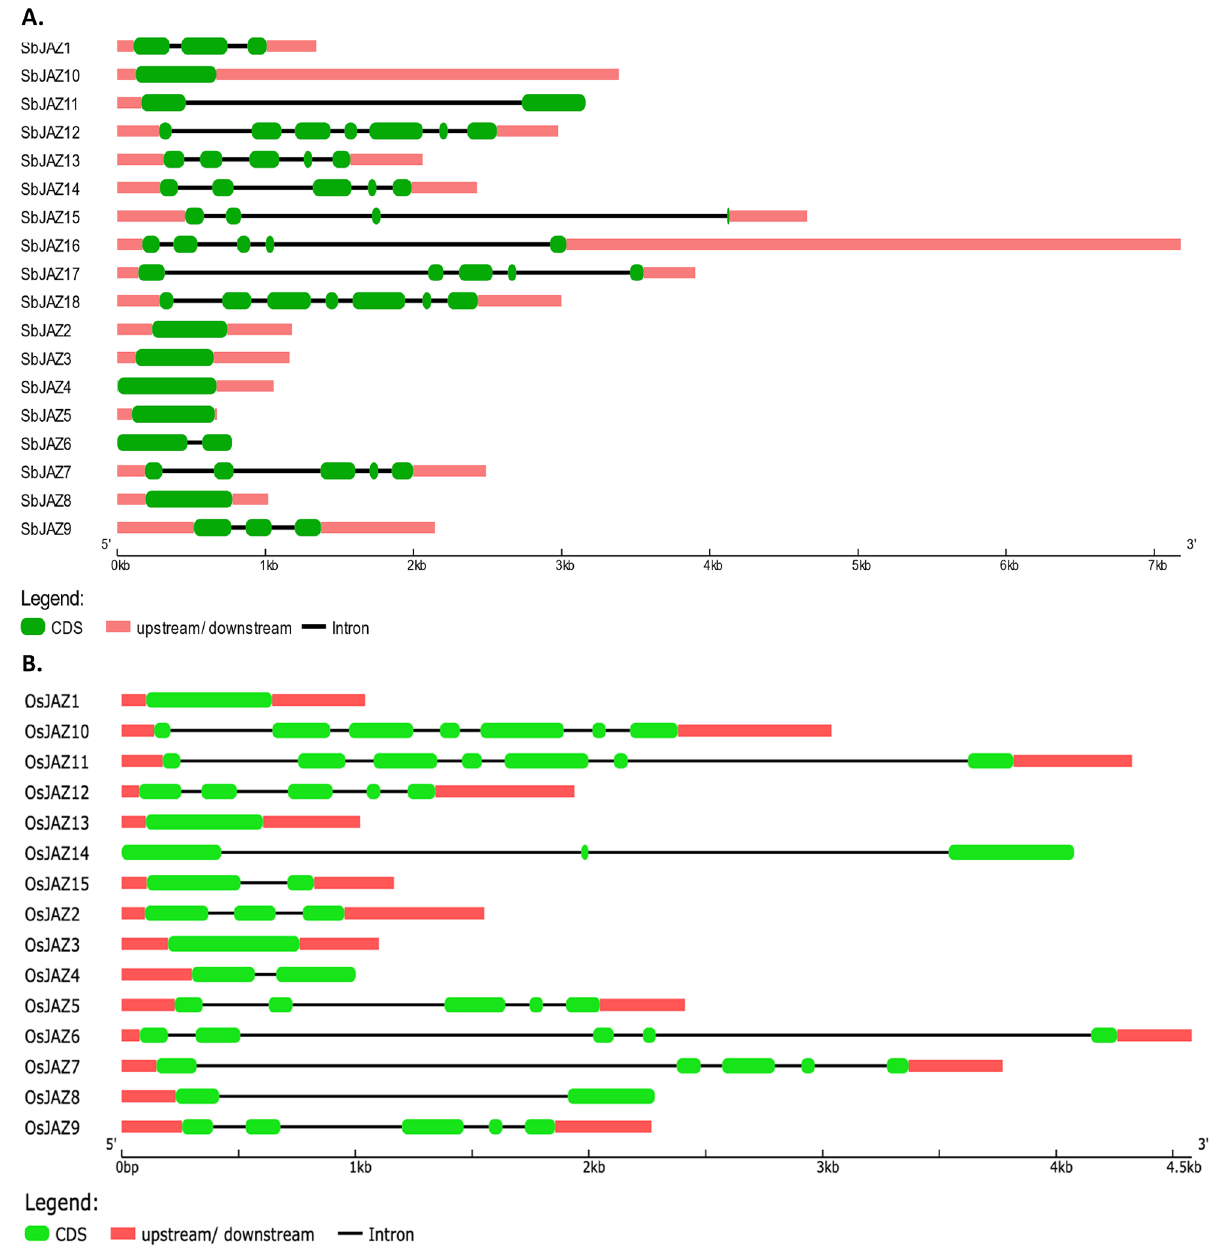
Figure 3. The schematic genomic structure for each SbJAZ gene ( A ) and OsJAZ ( B ) was generated using gene structure display server (GSDS). The size of coding DNA sequence (CDS), introns and untranslated regions are proportional to their sequence